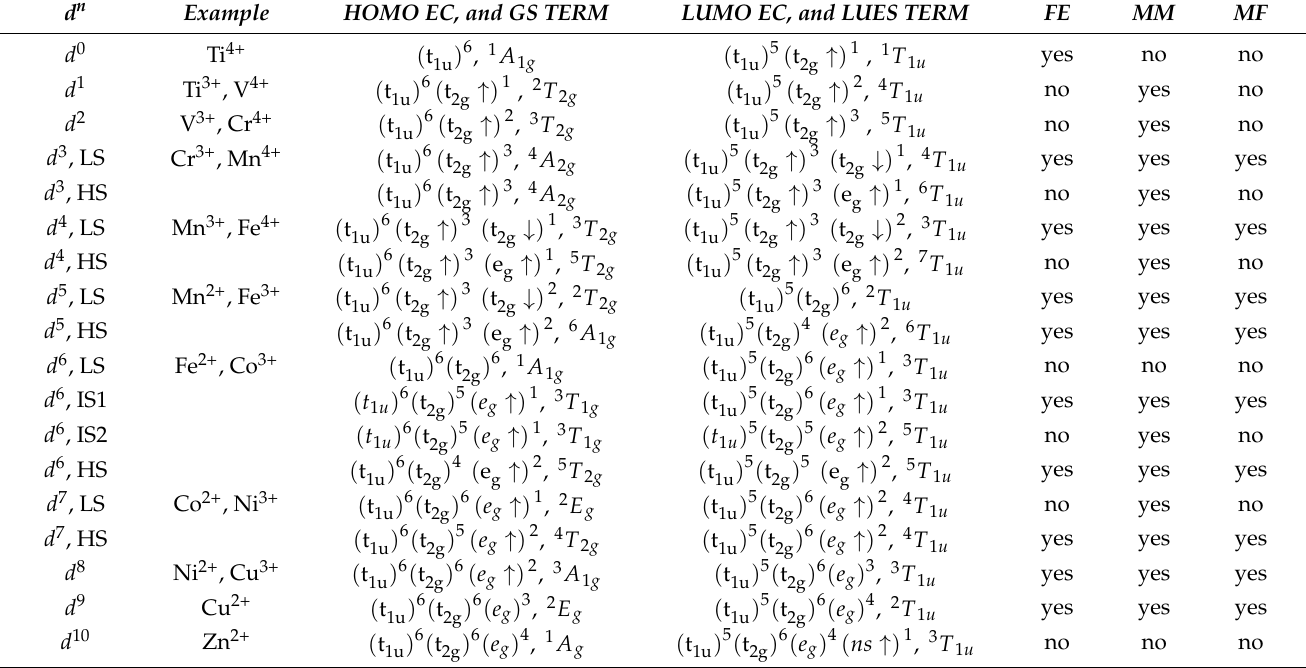
5 = ( t ↑ ) 3 ; (t ↑ ) 3 ↓ ) 3 ( t ↓ ) 2 ( t 1u ) 1u 1u 1u 1u